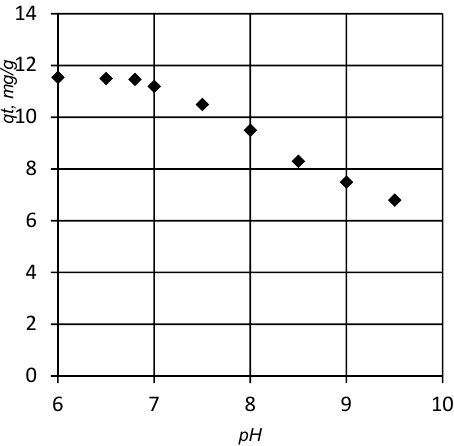
Figure 11. Influence of pH on diazepam sorption by natural Na-montmorillonite; T = 37.0 ± 0.1 °C; Ci = 18mg/L; and S:L ratio = 1 g/L.